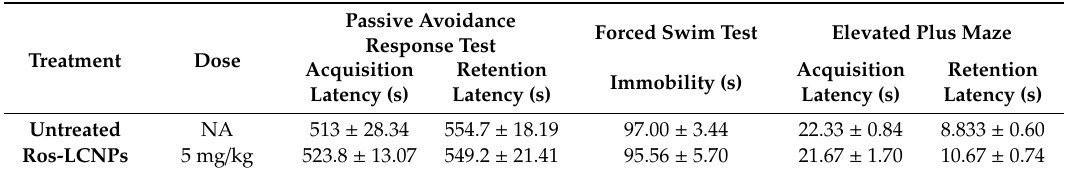
Table 4. E ff ect of Ros-LCNPs on passive avoidance response test (step down latency model), forced swim test and elevated plus maze test (transfer latency model). Data are expressed as mean ± SEM; n = 6 in each group, ANOVA followed by Dunnett’s